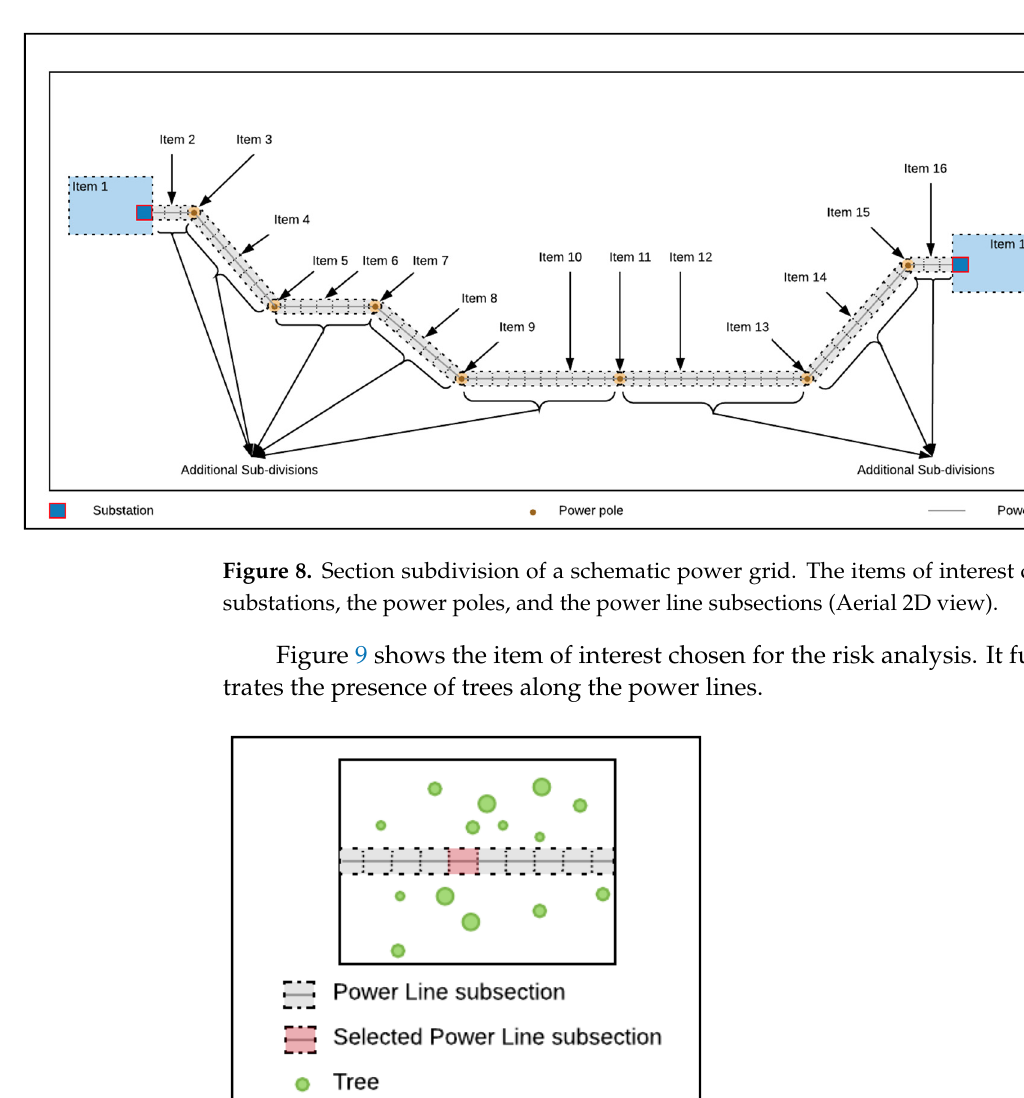
Figure 9. Selection of a power-line subsection as an item of interest for a risk analysis. The existence of the vegetation hazard is indicated by the presence of trees in the surrounding of the power line. (aerial 2D view).